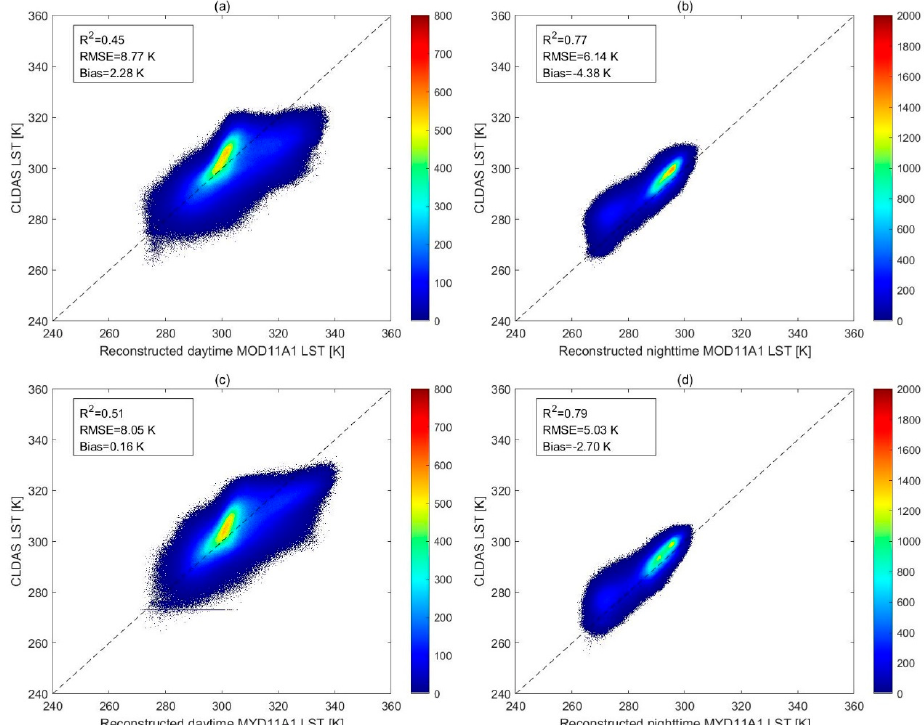
Figure 13. Density scatterplots between the reconstructed LSTs of ( a ) MODLSTD_Rec_SG; ( b ) MODLSTN_Rec_SG; ( c ) MYDLSTD_Rec_SG, and ( d ) MYDLSTN_Rec_SG, and the corresponding CLDAS LSTs from June to August 2017. Color bar represents the counts of the points falling in each square.